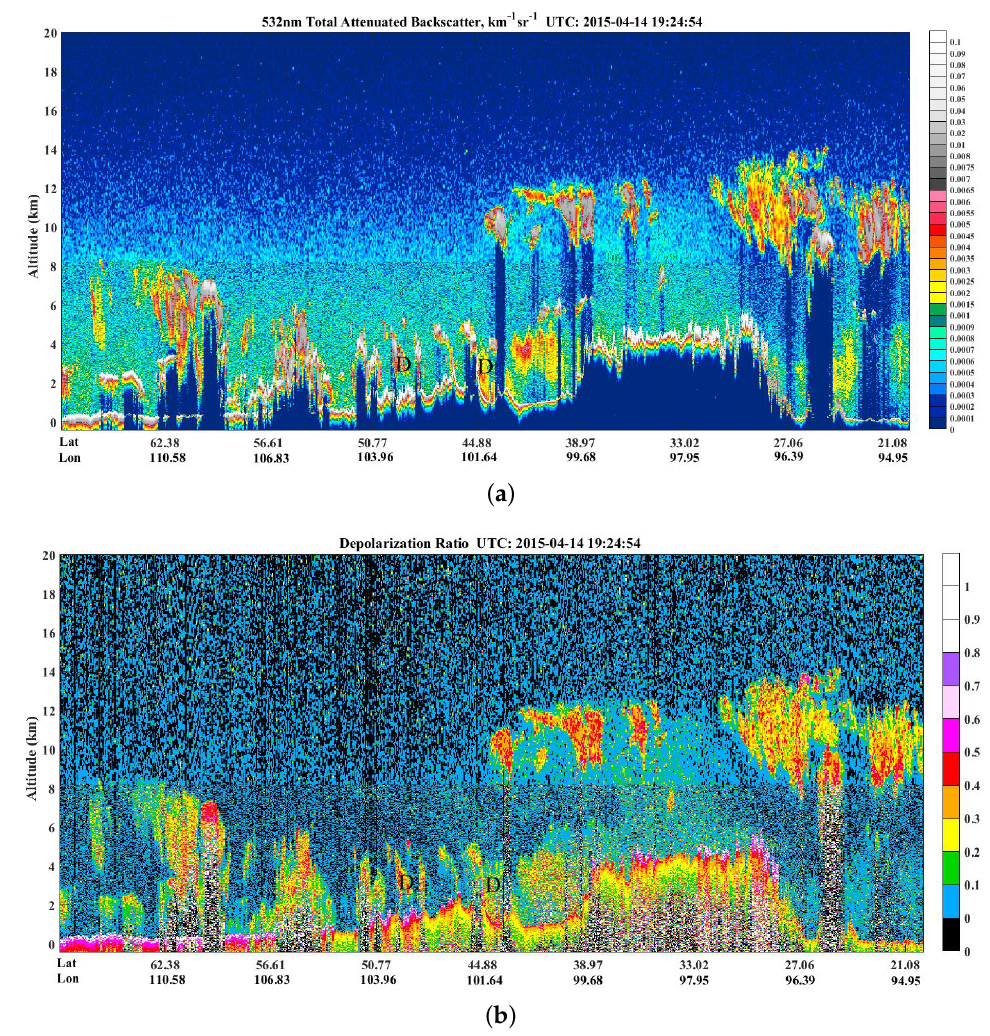
Figure 5. Total attenuated backscatter and depolarization ratio at 532 nm wavelength in the range of (20.00 ◦ N, 94.69 ◦ E)~(68.00 ◦ N, 115.88 ◦ E) on 14 April 2015 (UTC). The horizontal coordinate represents the latitude and longitude, the vertical coordinate represents the altitude. The letter “D” designates the dust layer. ( a ) Total attenuated backscatter, and the blue to white color bar represents the value of the total backscatter at 532 nm wavelength; ( b ) Depolarization ratio and the black to white color bar represent the value of the depolarization ratio at 532 nm